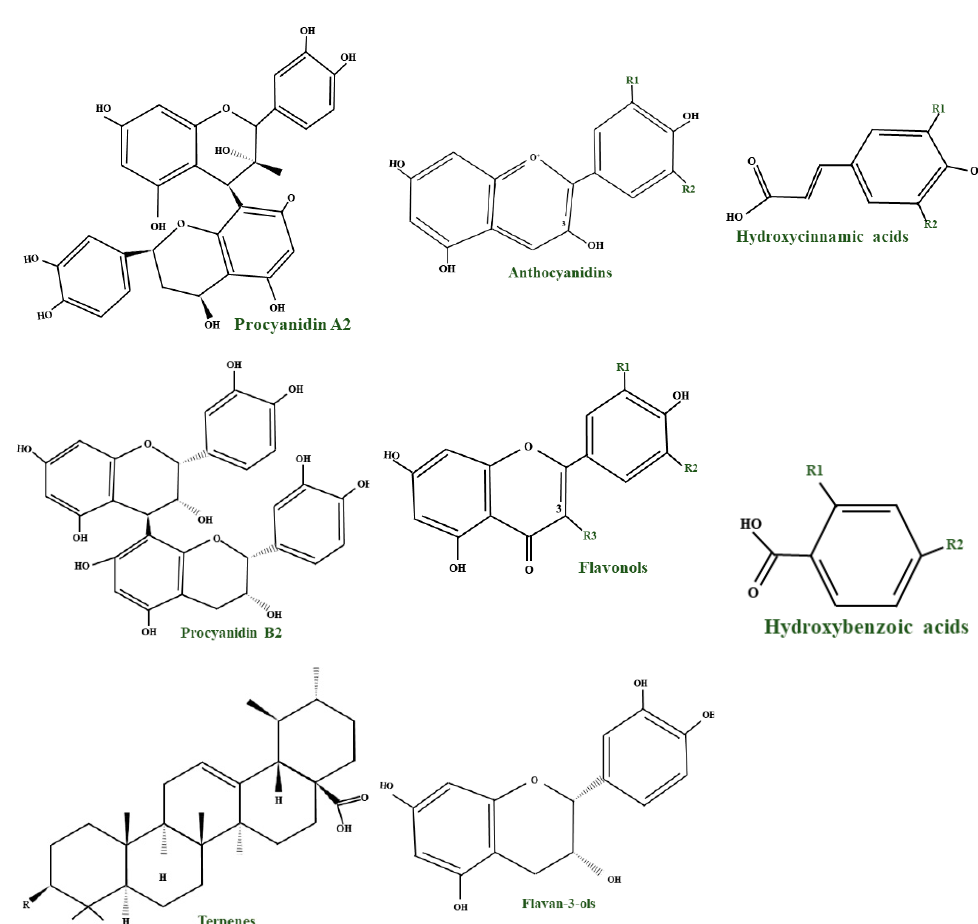
Figure 3. Bioactive compounds found in cranberry; figure adapted from [115].